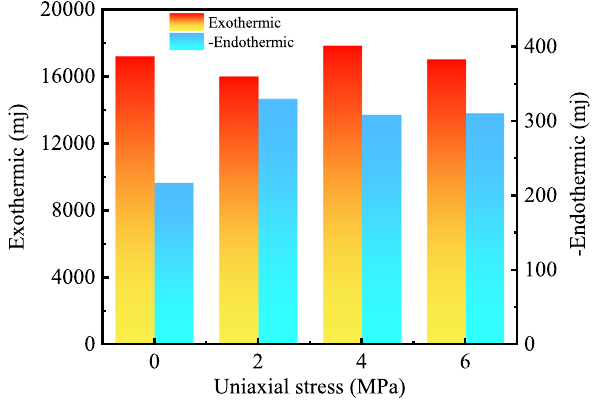
Fig. 6 Changes in heat release of coal re-ignition under different uni- axial